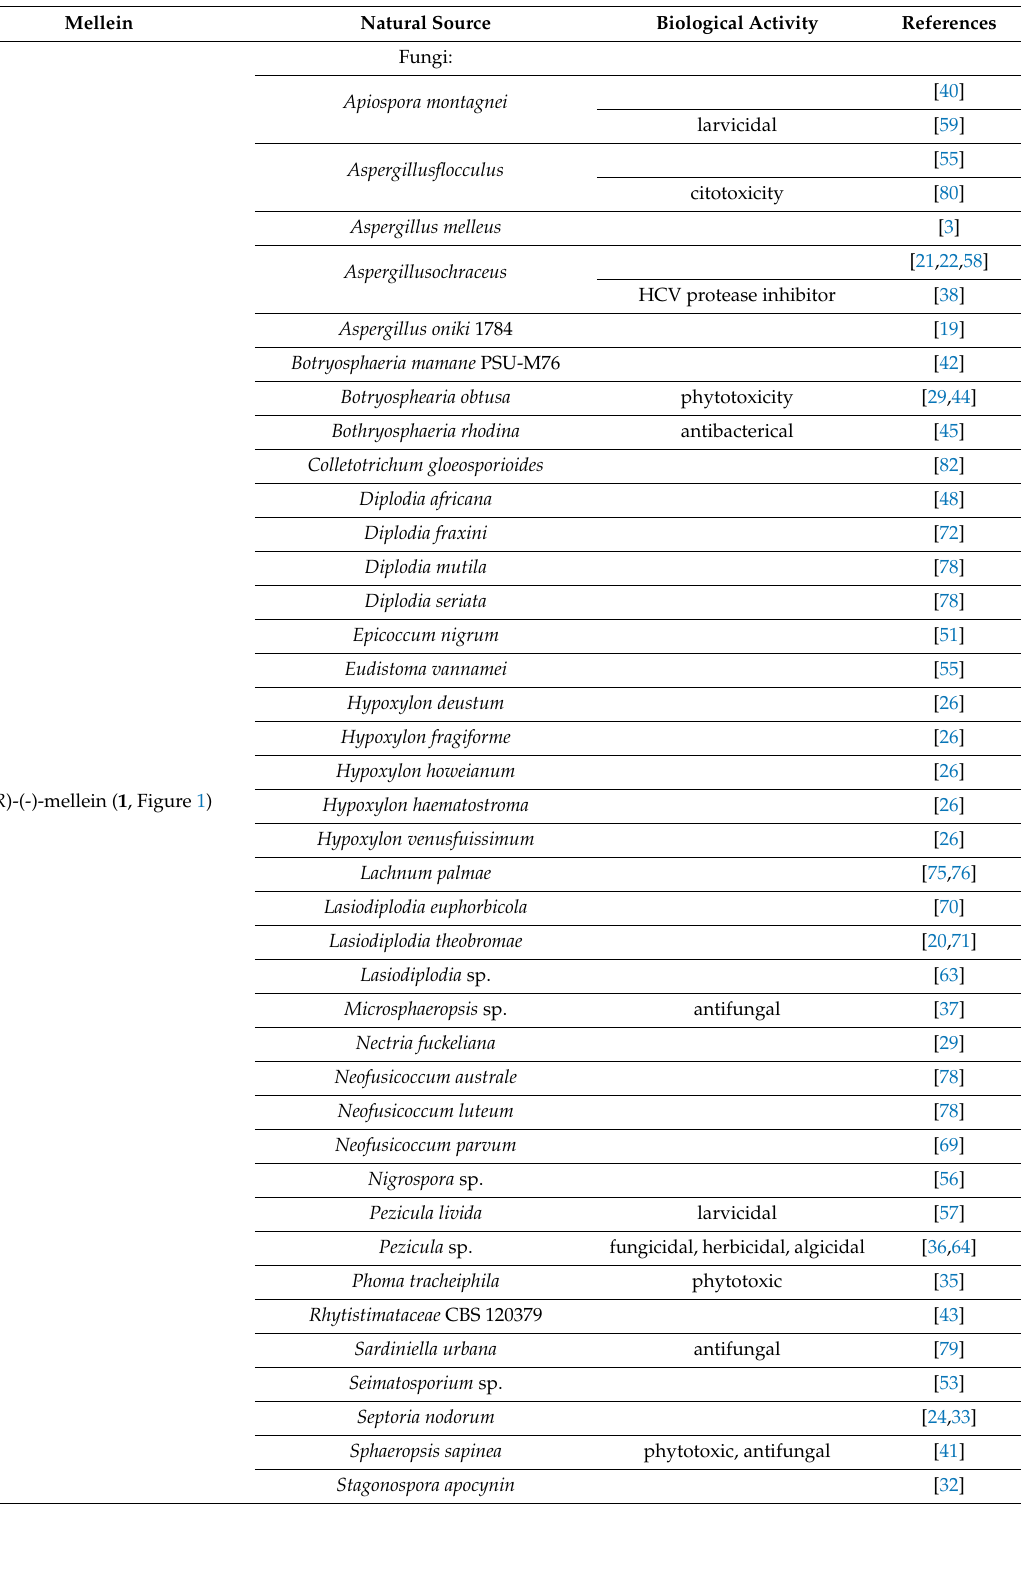
Table 1. Naturally-occurring melleins, their natural sources and their biological activities.